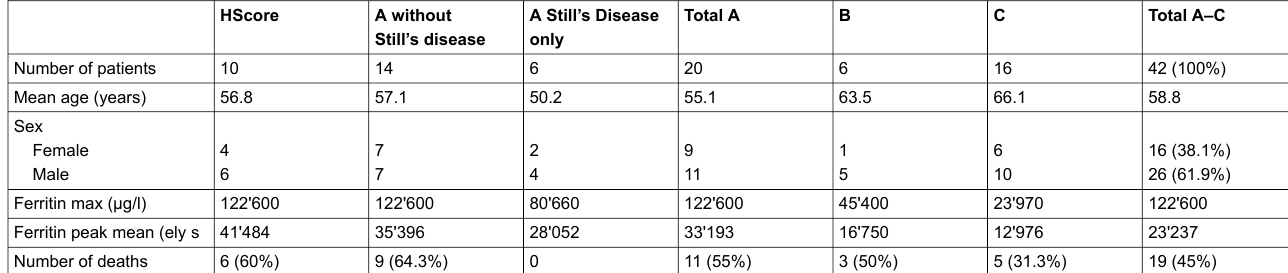
Table 1: Grouping of the patients suffering from haemophagocytic lymphohistiocytosis (HLH) using HScore and the algorithm of Emmenegger [15], fulfilling at least five of eight required criteria: (A) with and without patients suffering from Still's disease (B) fewer than five of eight criteria and thus HLH is less probable, (C) patients most likely suffer from another disease with liver